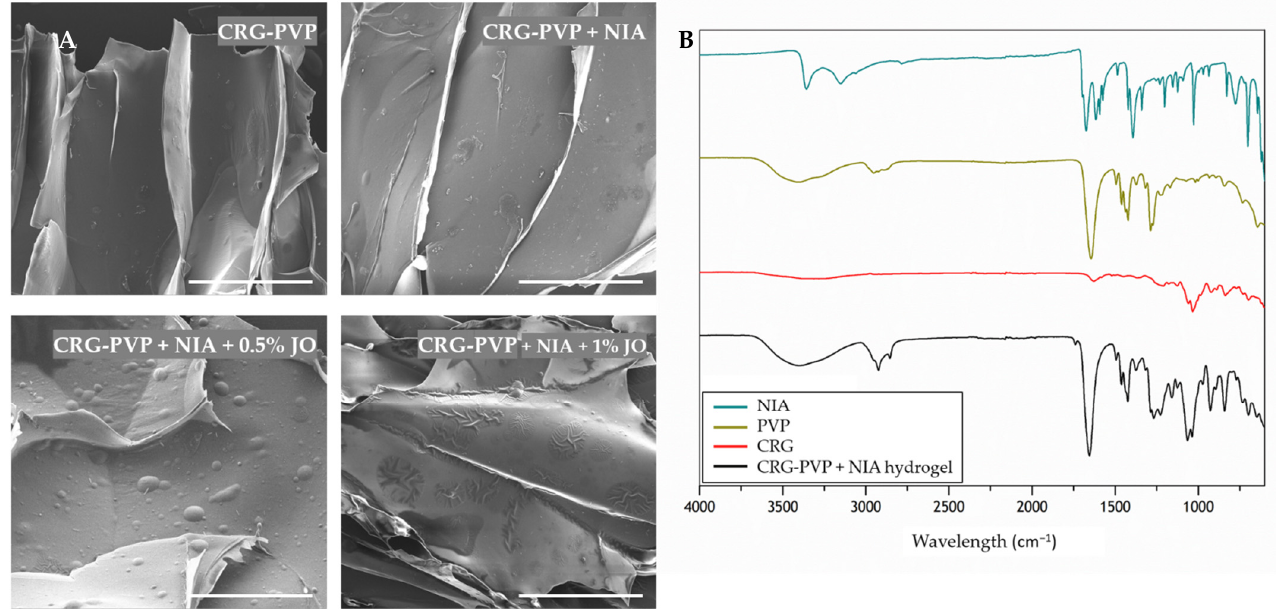
Figure 1. Analysis of the hydrogels morphology ( A ) and chemical interactions ( B ). SEM of CRG-PVP hydrogel matrix with NIA and jojoba oil in different amounts (0.5% and 1%). Scale bar 200 μ m, amplification of 500x. FTIR spectra of CRG-PVP NIA-loaded hydrogel and all reference compounds in relation to transmittance.